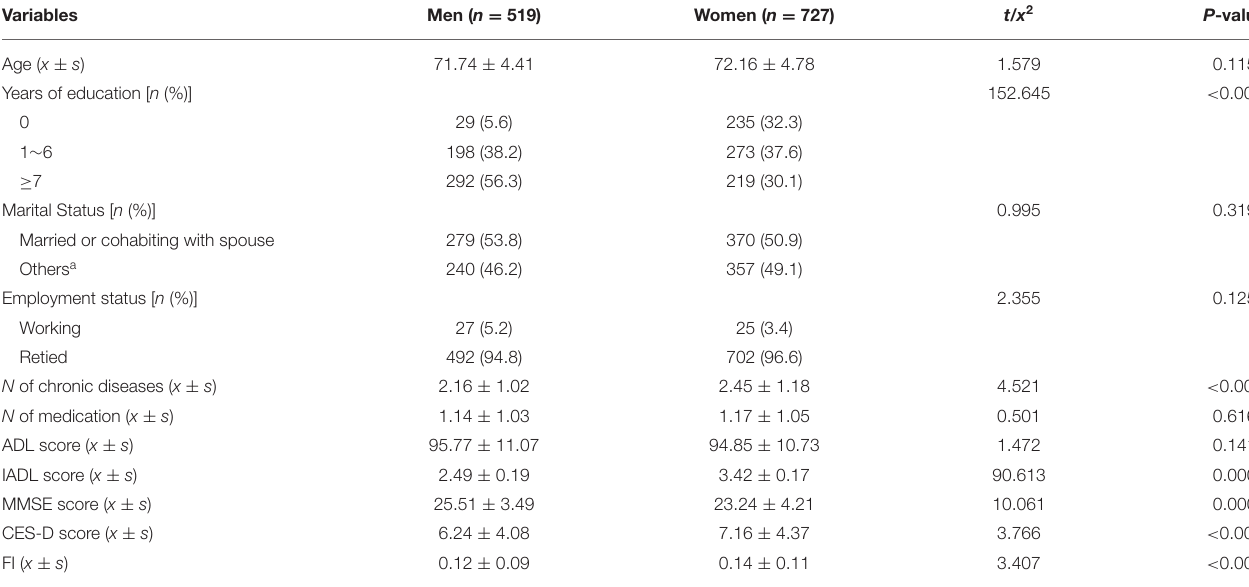
TABLE 1 | Baseline characteristics of the study sample as separated by sex.